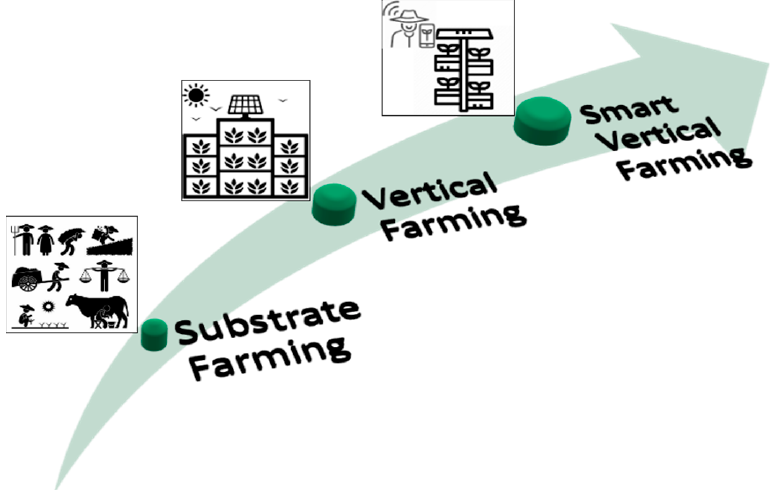
Figure 1. Evolution of smart vertical farming.